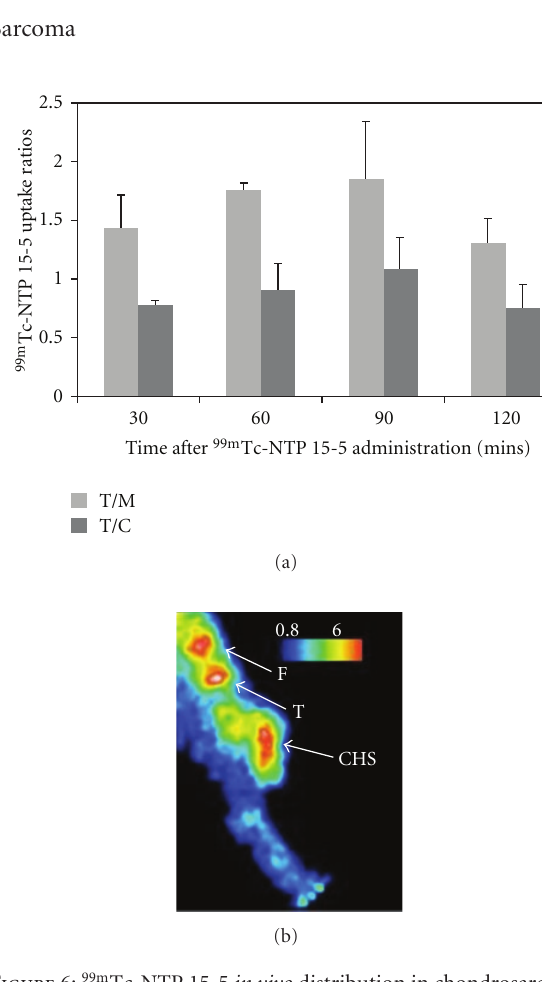
Figure 6: 99m Tc-NTP 15-5 in vivo distribution in chondrosarcoma; (a) 99m Tc-NTP 15-5 uptake ratios as a function of delay between iv administration of tracer and acquisition; (b) Scintigraphic image obtained for a representative animal, for a delay of 30 min between injection and acquisition. Abbreviations: F: femoral condyle; T: tibial plateau; CHS: chondrosarcoma.